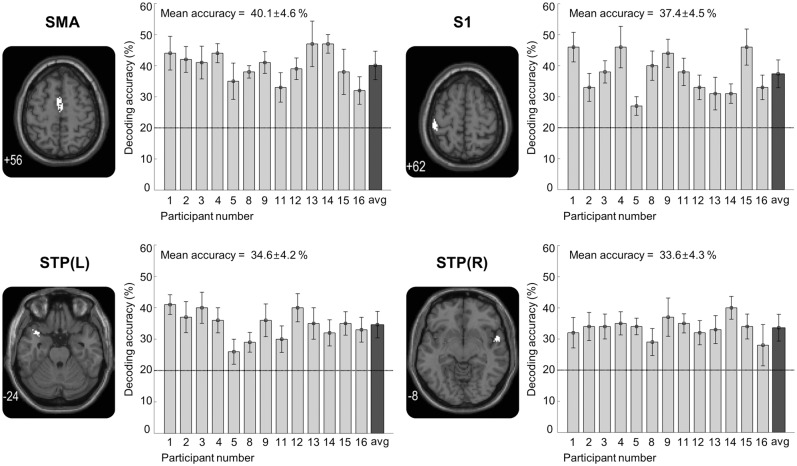
Results of the whole brain searchlight MVPA.Searchlight analysis identified four brain regions showing significant decoding performance in the prediction of five different levels of roughness. For each region, the left panel shows a sagittal slice of the brain (Z-coordinate of slice indicated in bottom left corner). The right panel shows the decoding accuracies for each of the 13 participants and the rightmost value indicates the average accuracy across the participants. Error bars indicate standard errors and a chance level is marked by the dashed line (20%). Note that the data from participants 6, 7, and 10 were excluded from the analysis.